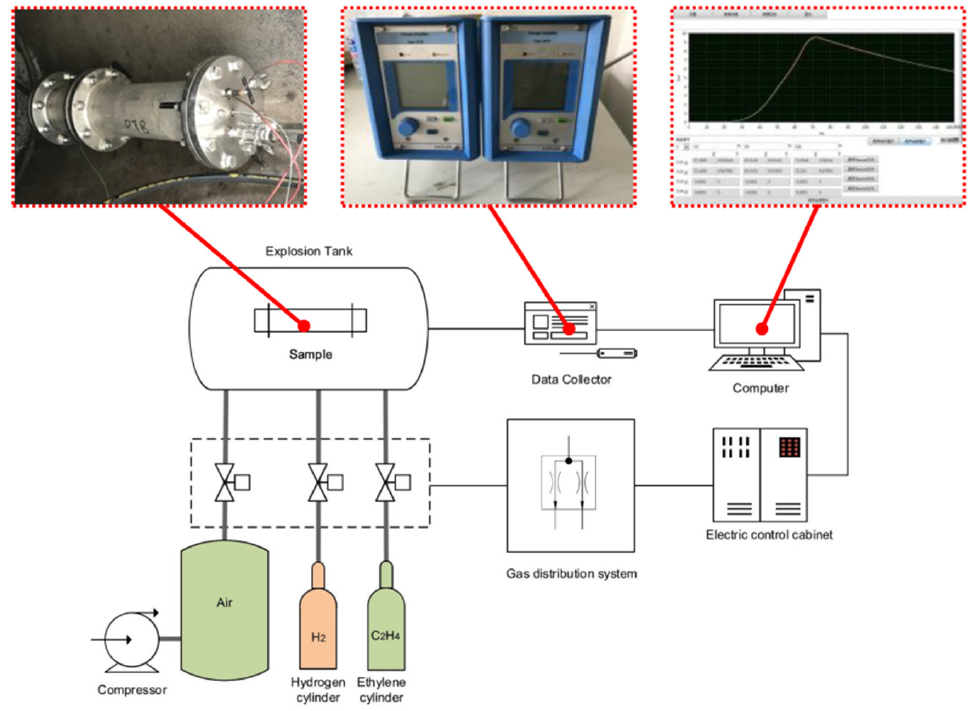
Figure 2. Schematic diagram of the experimental Figure 2 . Schematic diagram of the experimental device.